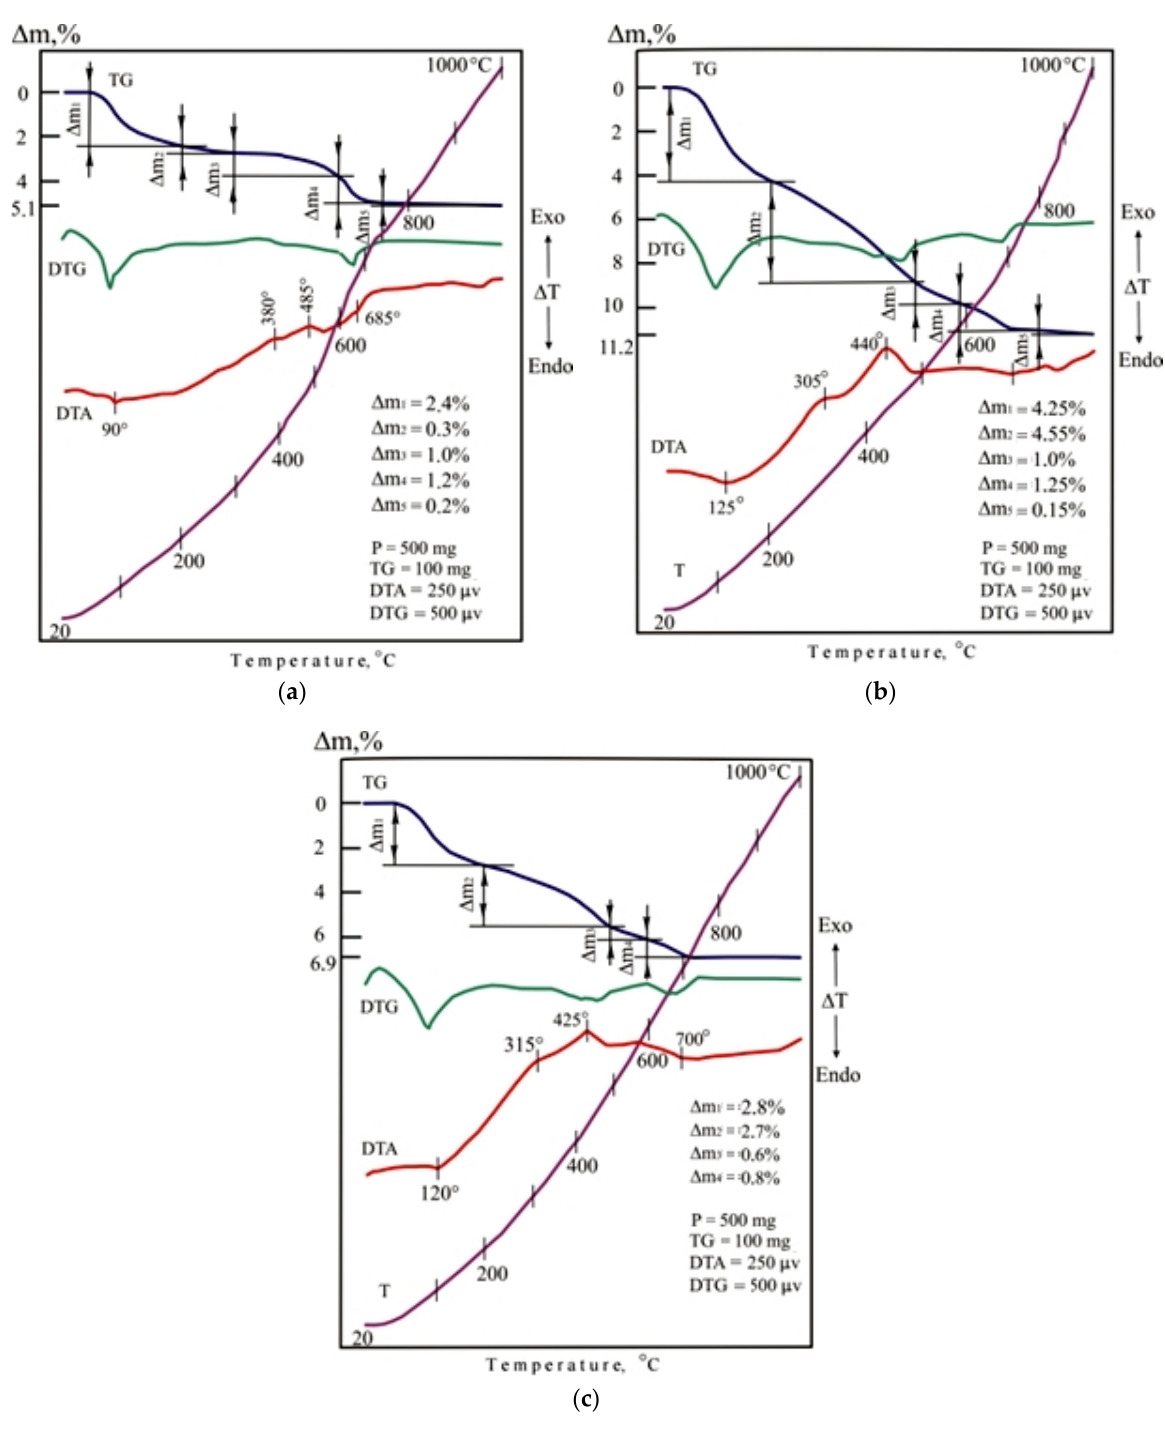
Figure 11. DTA patterns of the dry raw mixtures (without liquid glass): ( a ) CB11; ( b ) CB21; ( c ) CB31.